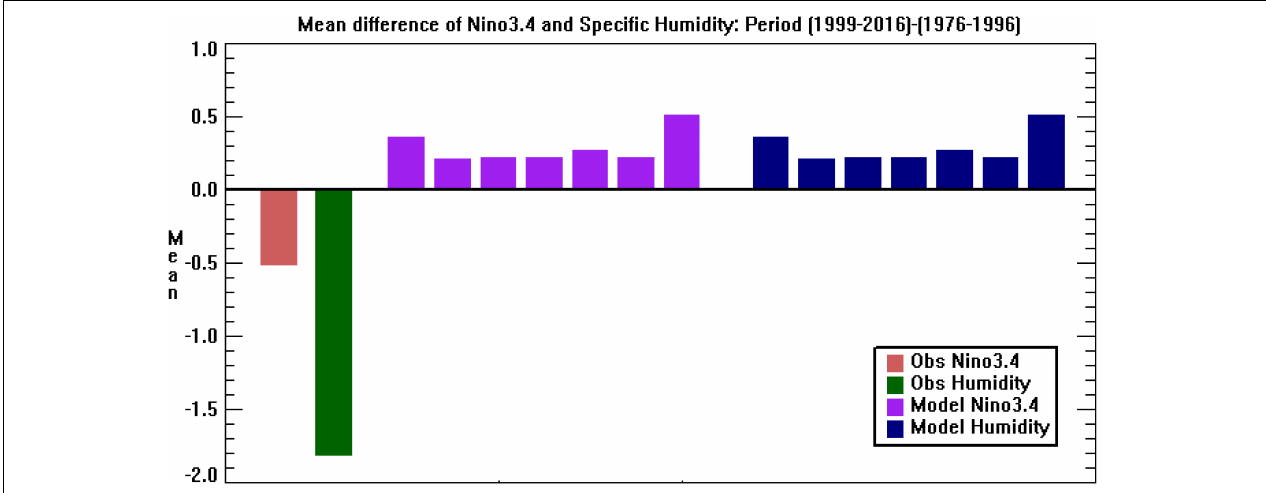
FIGURE 9 | Mean difference of Niño3.4 and specific humidity from period after 1999 to that from 1976 to 1996. First two bar plots are for Niño3.4 and specific humidity, respectively, from observed or reanalyses products. Results for seven different models are presented, purple for Niño3.4 and blue for specific humidity. Models shown are IPSL-CM5A-LR, NorESM1-M, MIROC-ESM, MIROC-ESM-CHEM, ACCESS1-0, CSIRO-Mk3-6-0 and IPSL-CM5A-MR, respectively. For rest other models, almost all suggest similarly and hence not